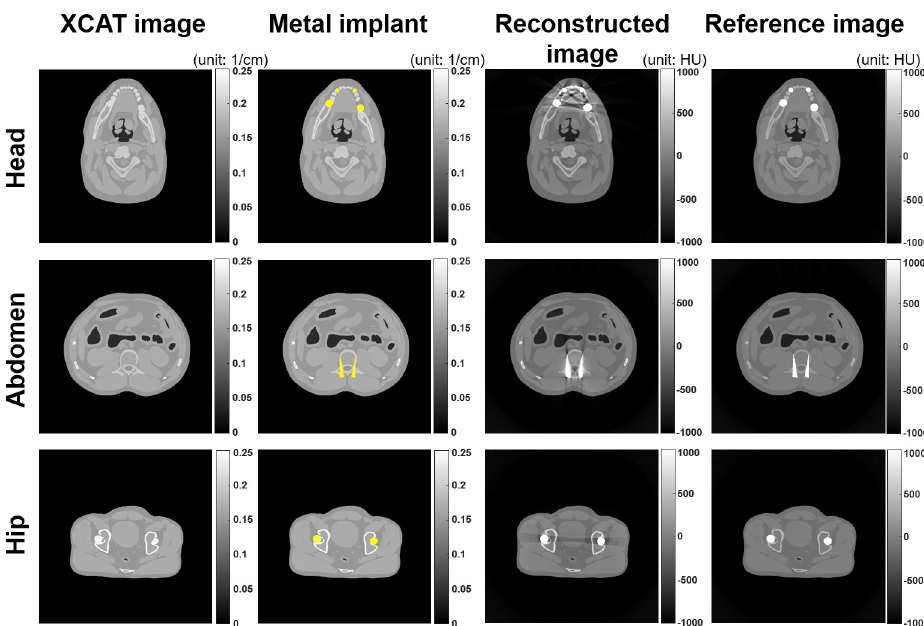
Fig 5. Representative images of the XCAT phantoms. Each row presents various parts of the human body. Each column presents the original XCAT image, metal implant positions (indicated by the yellow regions), reconstructed CT image with metal artifacts, and reference image without metal artifacts. The display unit for the XCAT image and metal implant is cm -1 . For reconstructed images and reference images, the display unit is the CT value in HU.